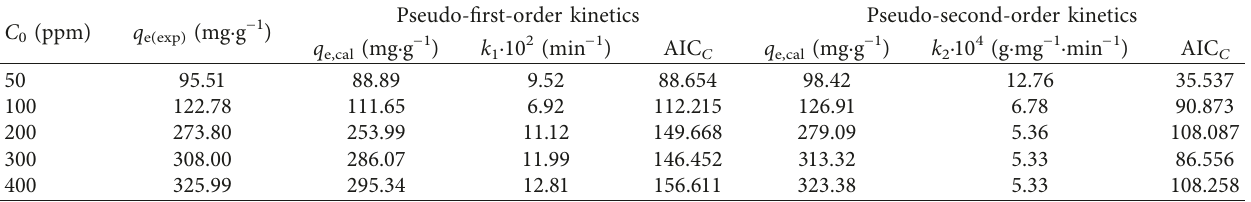
Table 4: Kinetic parameters for pseudo-first-order and pseudo-second-order kinetic models of RDB adsorption on MIL-101. Pseudo-first-order kinetics C 0 (ppm) q e(exp) (mg · g − 1 )